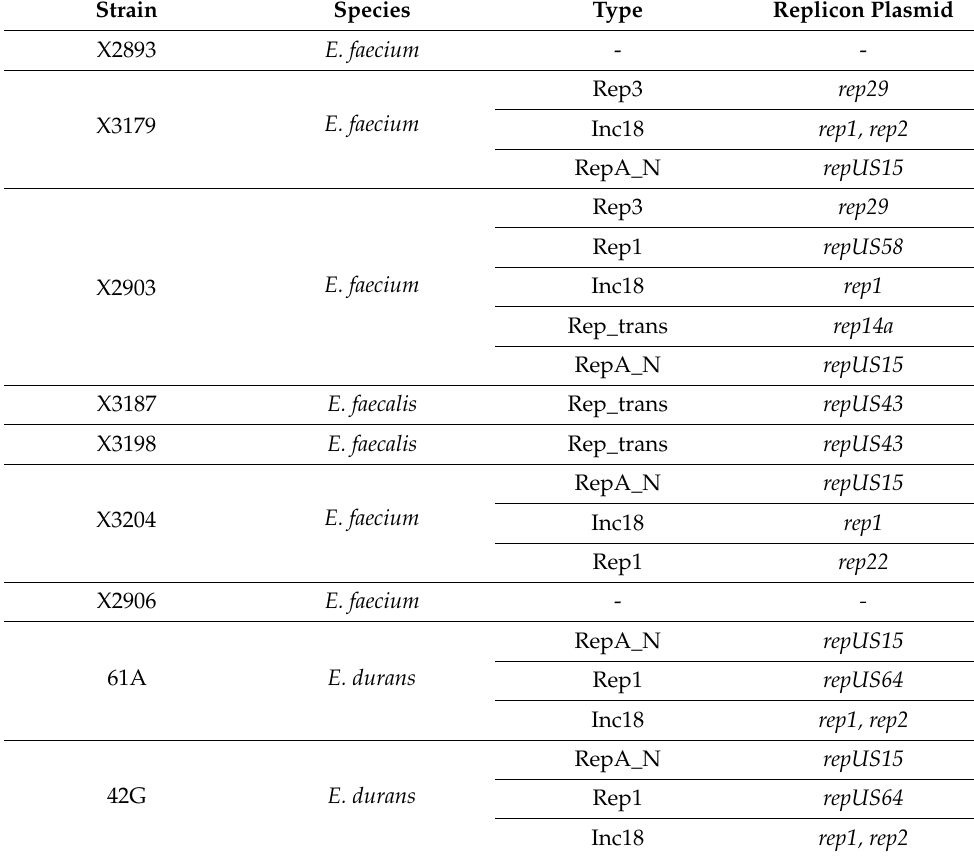
Table 6. Plasmidome of the 12 BP+ enterococci detected by